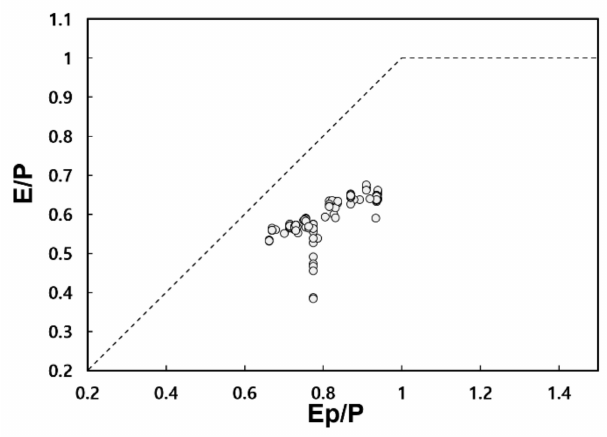
Figure 7. Distribution of hydroclimatic condition in Budyko space of 154 watersheds in the past period (1970–1984) in terms of the aridity index (E p /P) and evaporation index (E/P).